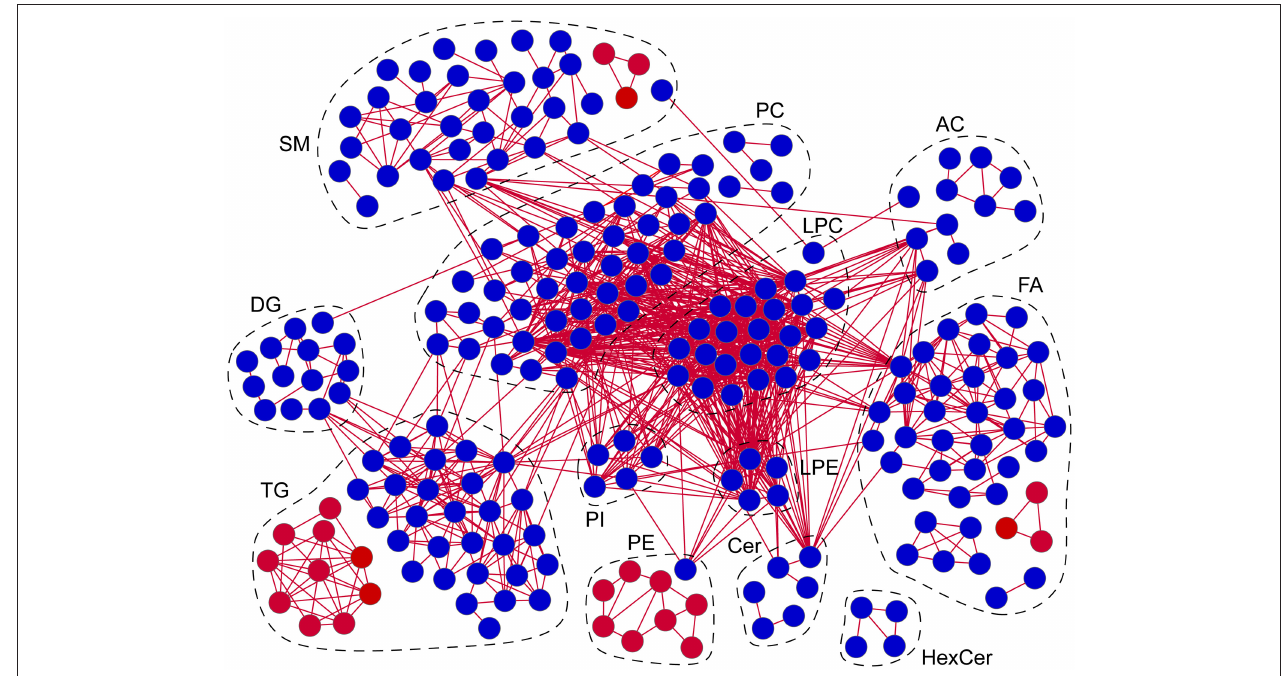
FIGURE 6 | Correlation networks of lipid alterations in patients with AD. Red/blue circles: lipids significantly increased/decreased in patients with AD. Red lines: positive correlations. Absolute values of Spearman correlation coefficients were set to be higher than 0.75. n = 67. FA, fatty acid; AC, acyl carnitine; Cer, ceramide; HexCer, hexosylceramide; SM, sphingomyelin; LPC, lysophosphatidylcholine; LPE, lysophosphatidylethanolamine; PC, phosphatidylcholine; PE, phosphatidylethanolamine; PI, phosphatidylinositol; DG, diglyceride; TG,